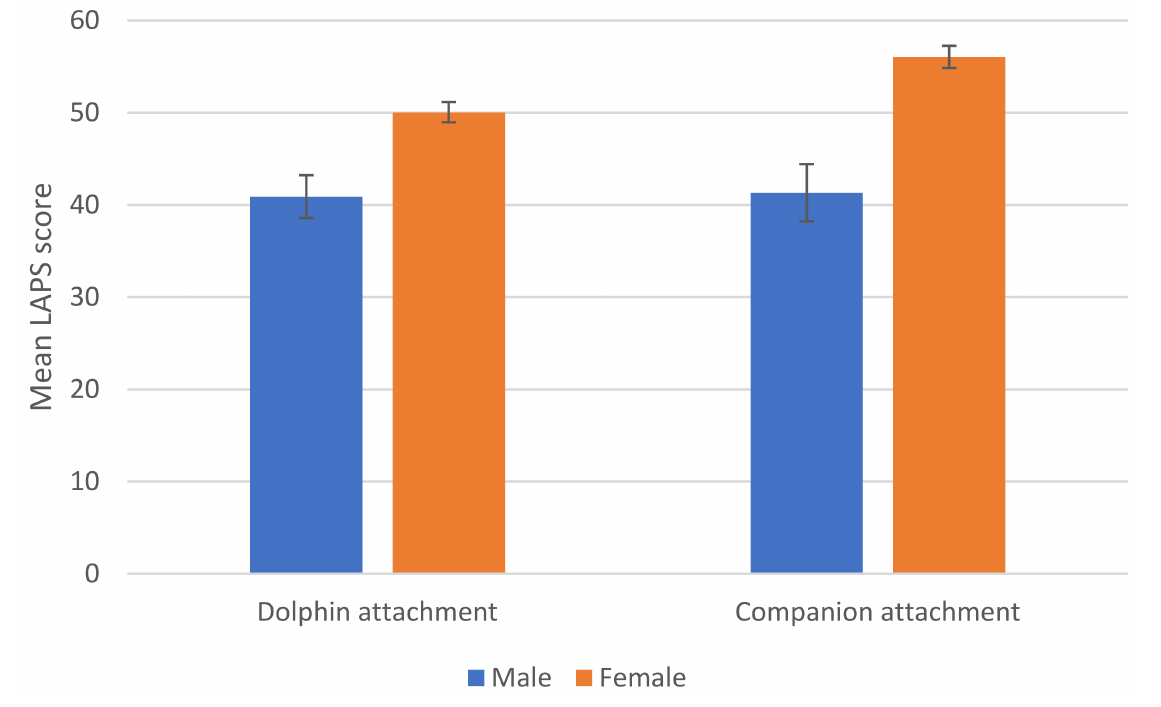
Figure 1. Mean dolphin and companion attachment scores ( n = 27, 89, 25,